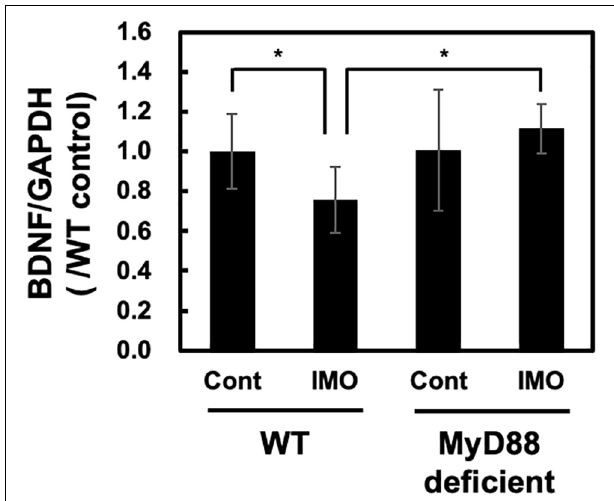
FIGURE 3 | BDNF levels in MyD88-deficient mice exposed to immobilization stress. Immobilization stress-induced reduction in BDNF mRNA level was ameliorated in MyD88-deficient mice. Hippocampus samples were obtained 8 h after exposure to immobilization stress and subjected to real-time PCR analysis. Values are presented the ratio to WT control group as means ± SD. Two-way ANOVA with Tukey’s honestly significant difference post hoc comparison was performed. The results of two-way ANOVA were as follows: immobilization: F (1) = 0.766, p = 0.389; genotype: F (1) = 5.7515, p = 0.024; immobilization × genotype interaction: F (1) = 5.391, p = 0.028. The result of post hoc test were as follows: * p = 0.047, WT-cont vs. WT-IMO, *p = 0.128, WT-cont vs. deficient-IMO (WT-cont: n = 10; WT-IMO: n = 10; MyD88 deficient-cont: n = 5, MyD88 deficient-IMO: n =